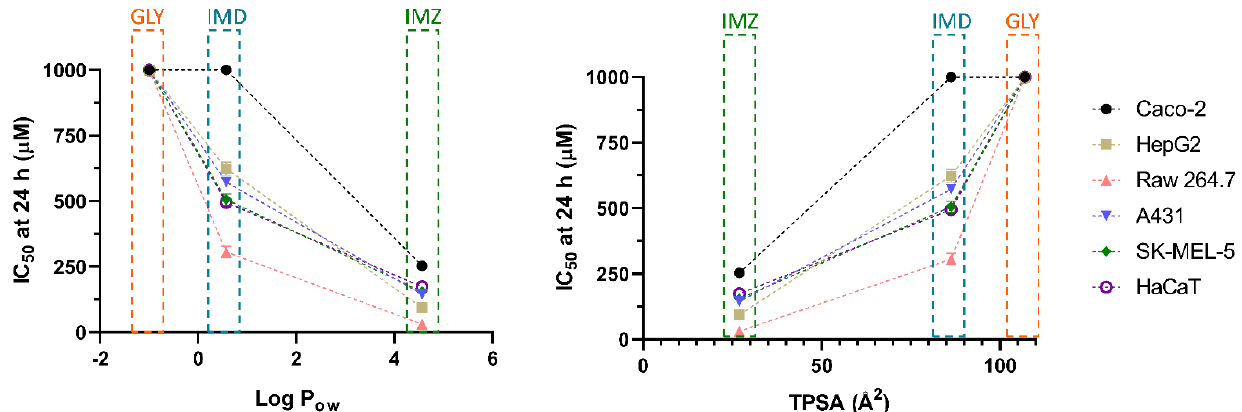
Figure 5. Correlation between Log P ow ( left ) and TPSA ( right ) with the IC 50 values obtained from in vitro cytotoxicity assays (see Table 1), for cells exposed for 24 h.